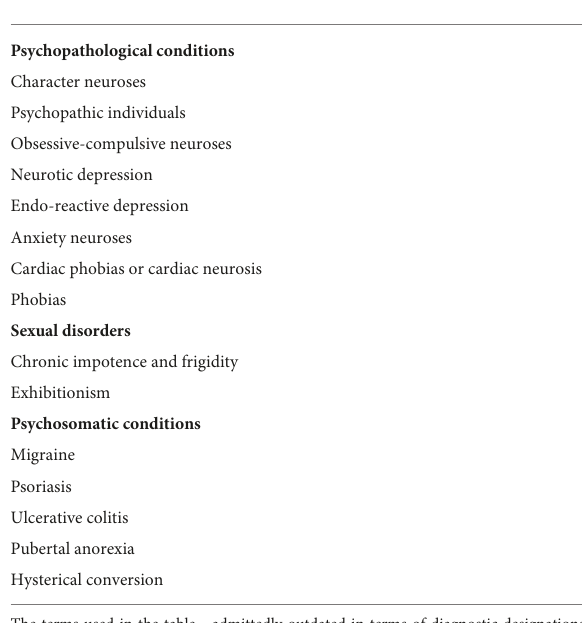
TABLE 2 Main indications of psycholytic therapy as issued by the European Medical Society of Psycholytic Therapy (EPT) (42).